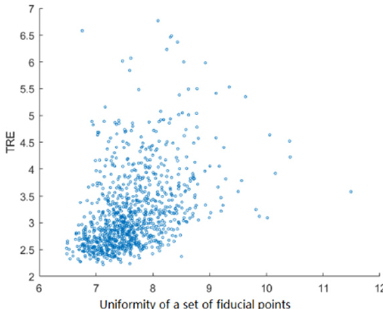
Figure 6. Relationship between uniformity of a points set and TRE.